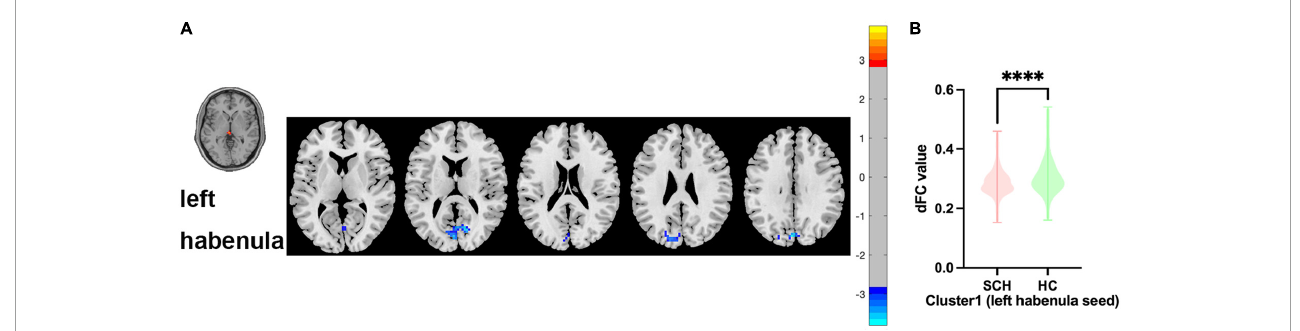
FIGURE2 Brain regions showing abnormal dFC values between SCH and HC groups in MNI space using left habenula as seed. (A) Significant dFC value differences were observed in cluster1 (bilateral cuneus gyrus, bilateral calcarine gyrus) using left habenula as seed. (B) Altered dFC values in cluster1 between SCH and HC groups using left habenula as seed. ****Significant at voxel-wise p < 0.005, cluster-wise p < 0.05 (2-tailed).